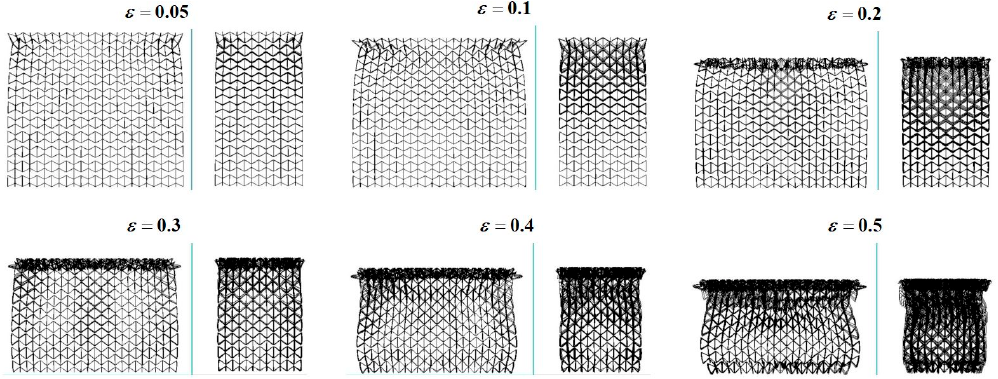
Figure 5. Deformation process of the 3D re-entrant auxetic structure under the crushing velocity v c = 15 m/s.